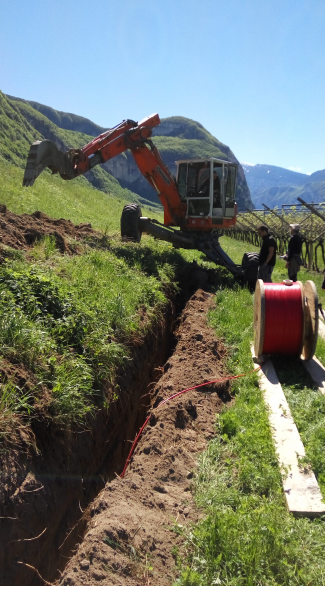
Figure 10. A trench dug at the downstream toe of a levee for the installation of the optical fibre cable (visible at the right) for a Raman-DTS monitoring